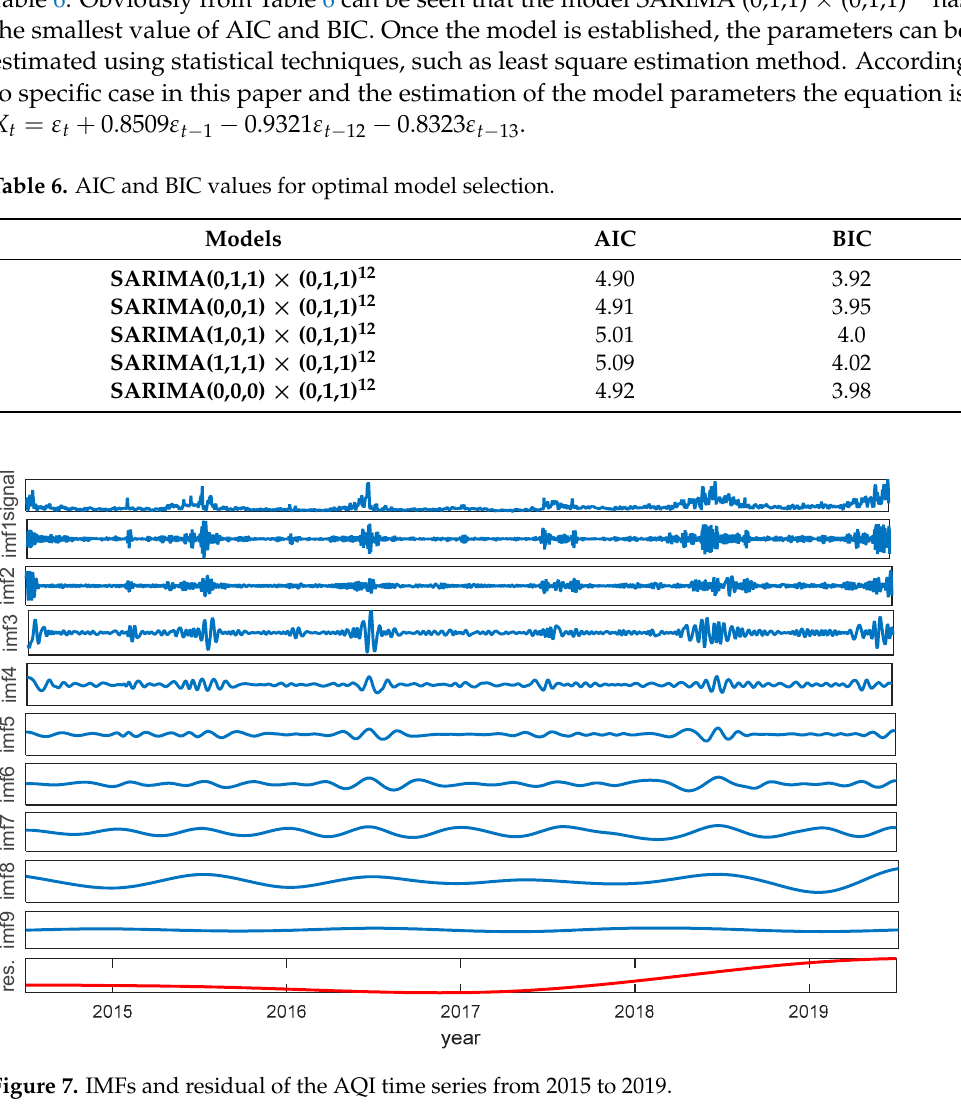
( b ) Figure 8. ( a ) Original and forecasted AQI using hybrid EMD-SARIMA model ( b ) results shown for January only. Table 7. Common metrics result for model SARIMA (0, 1, 1) × (0, 1, 1) 12. Metric